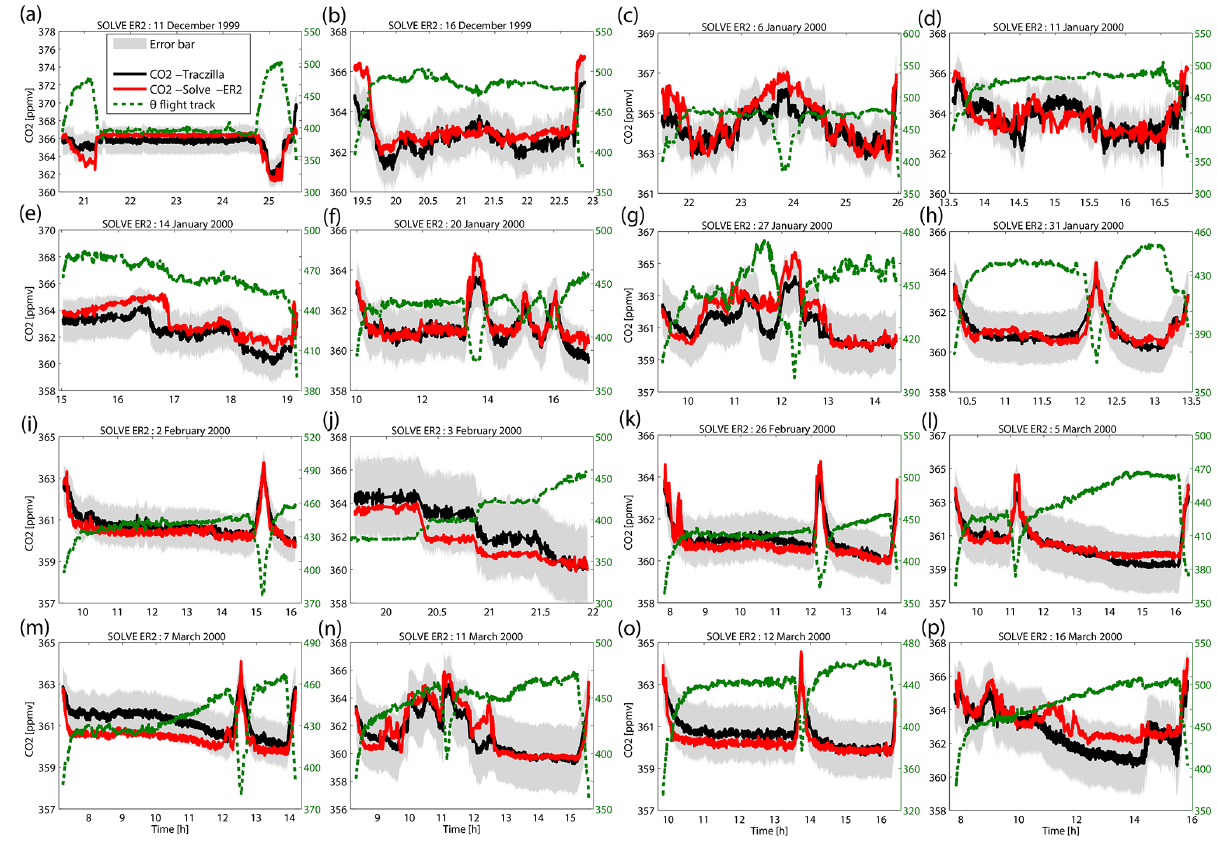
Figure 2. Comparison of the reconstructed monthly mean CO 2 from backward trajectories with aircraft measurements from the SOLVE campaign (Daube et al., 2002). Black shows reconstructed mean CO 2 along the ER-2 flight track using the TRACZILLA Lagrangian transport model. Red shows observed mean CO 2 . Green shows potential temperature of the ER-2 flight track. The grey shaded area indicates the 95% confidence interval calculated from the